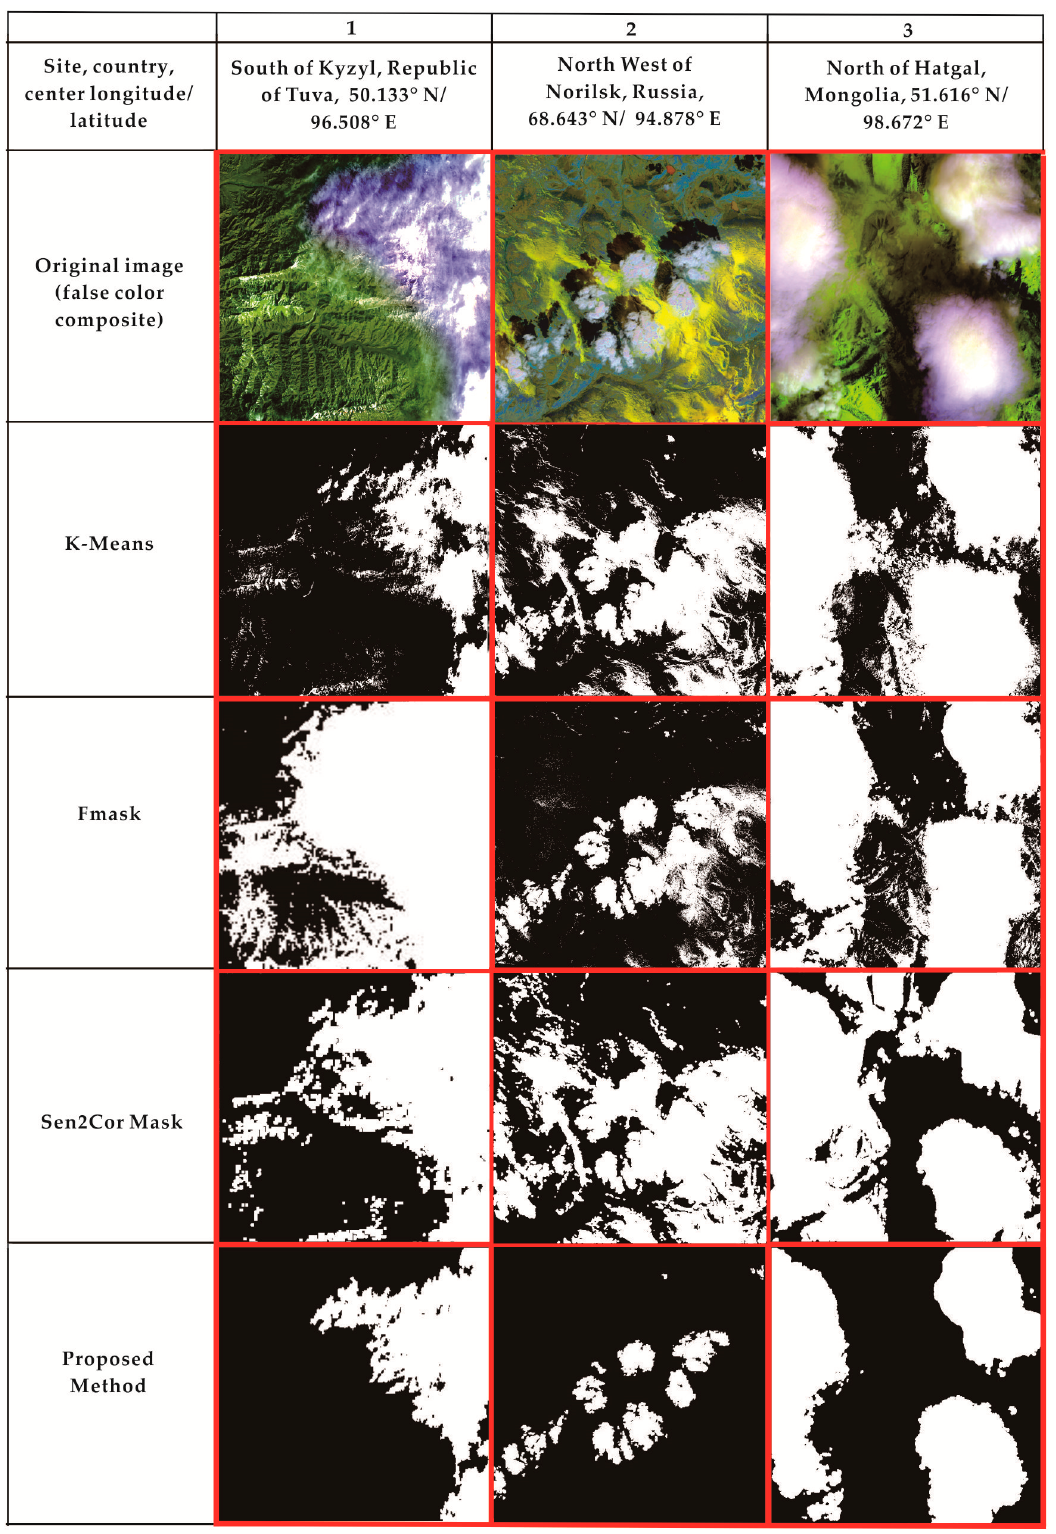
Figure 9. Comparison of the proposed technique against other methods, using imageries in different areas (cropping the regions of interest).